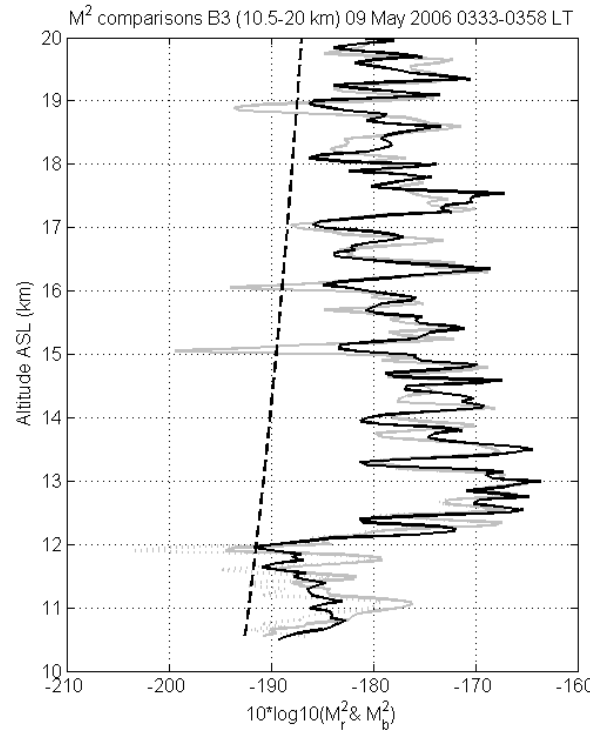
Fig. 4b. Same as Fig. 4a but for (grey solid line for the b